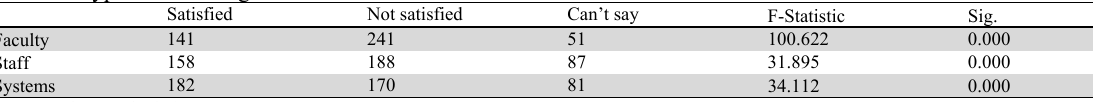
Results of hypothesis testing Satisfied Not satisfied Can’t